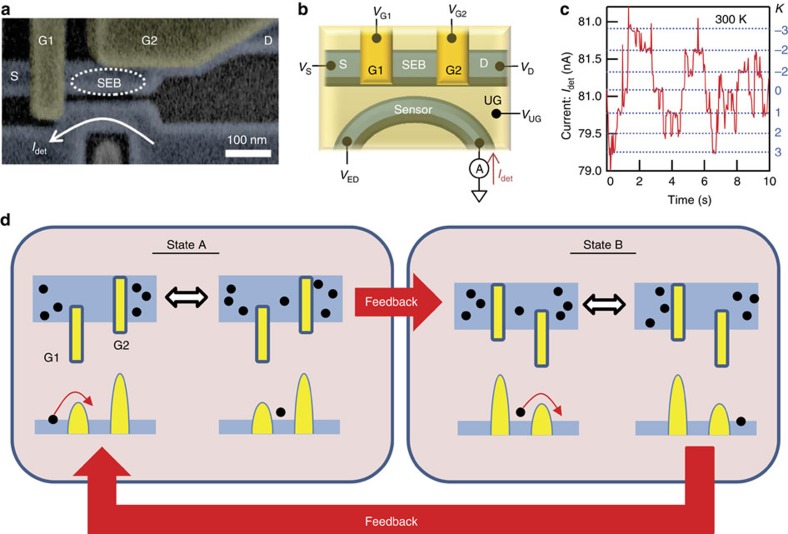
Device structure and operation schematics for Maxwell's demon.(a) False-color scanning electron microscope image and (b) schematics of the fabricated device. Above a silicon wire channel covered with a silicon dioxide, two gate terminals are formed to make field-effect transistors Gate(G) G1 and G2. The single-electron box (SEB) is electrically formed between the source (S) and drain (D) because G1 and G2 form energy barriers between the S and D as shown in d. Another channel functioning as a charge sensor is located close to the SEB. Above the whole area, there is an upper gate (UG), to which positive voltage VUG is applied. The details are explained in Methods section. (c) Single-electron detection at room temperature. Current flowing through the sensor is monitored and the abrupt reduction (increase) of current with the same step height means that a single-electron enters (leaves) the SEB. k is the deviation from the average of the number of electrons n in the SEB. We applied VUG=3.05 V, VED=1 V, VG1=−2.4 V, VG2=−1.95 V and VS=VD=−0.6 V. (d) Schematics of current generation by rectifying randomly moving electrons. The four upper and lower illustrations are schematics and energy-band diagrams along the S, SEB and D, respectively. For simplicity, they show how one electron is transferred, meaning Δn explained in the main text is one. We define state A(B) as the case that G1 opens (closes) and G2 closes (opens). When G1 opens (closes), its energy barrier lowers (rises) and an electron shuttles between the S and SEB faster (slower).